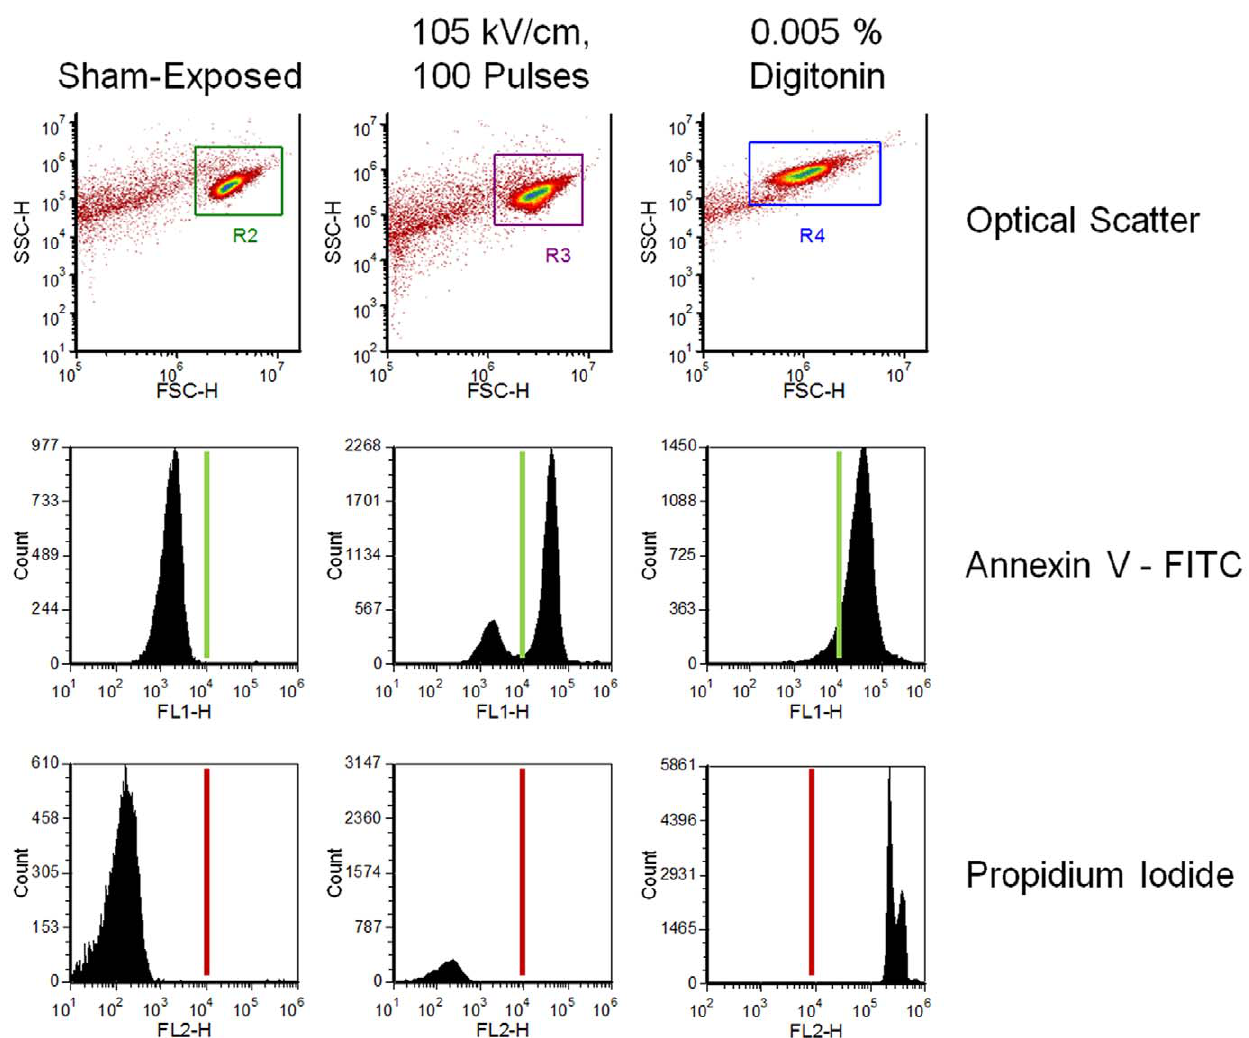
Figure 3. Binary determination of positive phosphatidylserine (PS) expression and propidium uptake by flow cytometry. Plots of the forward and side scatter (top) of sham-exposed cells, and cells exposed to either 105 kV/cm USEP or 0.005% digitonin (positive control for both dyes). Histograms of fluorescent count for Annexin V-FITC (middle) and PI (bottom) are also shown. The solid line represents the threshold used to determine the percent of the cellular population that stains positive for each dye.